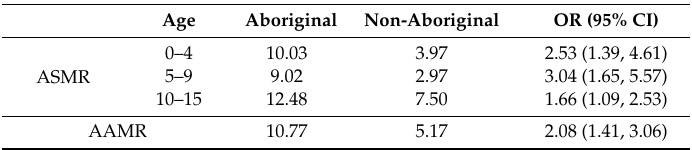
Table 2. Nine-year age-specific mortality rates (ASMR) and age-adjusted mortality rates (AAMR) per 100,000 population with odds ratios and 95% confidence intervals for Aboriginal and non-Aboriginal